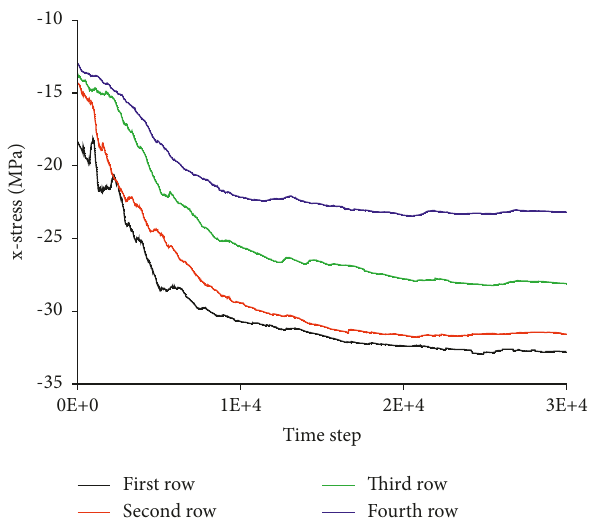
Figure 16: Upper average soil stress in the x -direction.